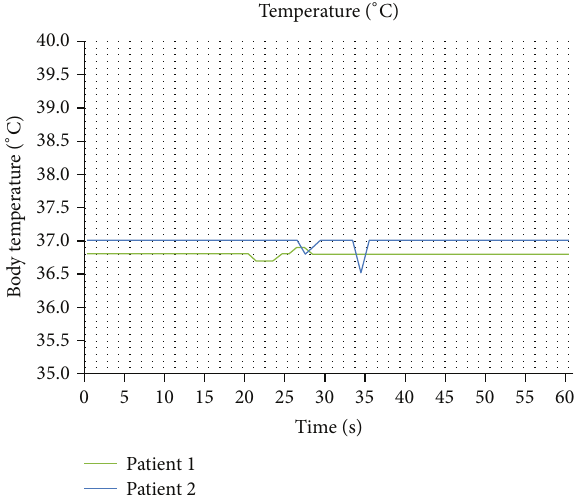
Figure 23: Comparison of the body temperature profiles for the two patients.